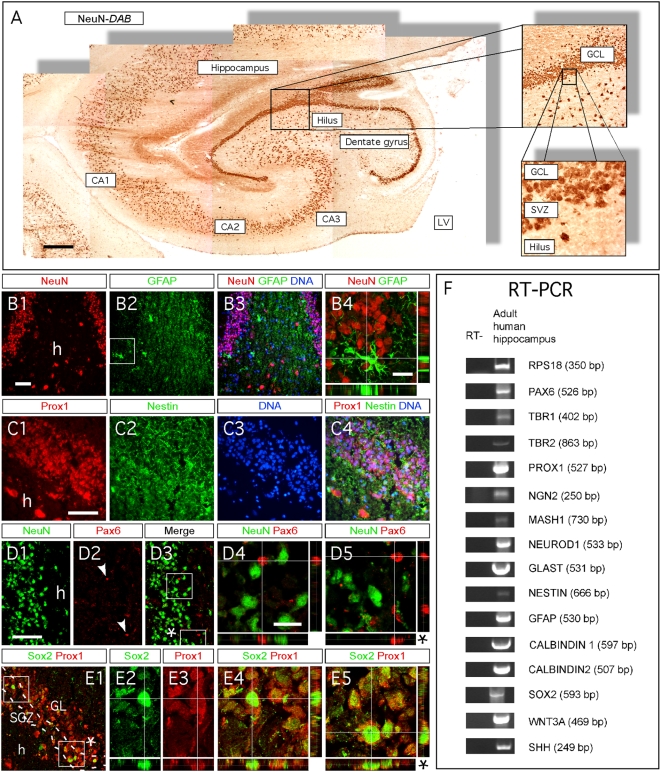
The expression pattern of markers for cell maturation during rodent hippocampal neurogenesis is conserved during human hippocampal neurogenesis.(A–E5) Indirect immunohistochemistries performed on human hippocampal coronal sections of 58-years-old individual. (A) DAB immunohistochemistry for the neuronal marker NeuN shows the neuro-anatomical structure of the hippocampus. (B1–B4) Mature granule neurons and astrocytes/radial glia-like cells express NeuN (green) and GFAP (red), respectively. (C1–C4) Neurons located in the DG express the granule neuron identity marker Prox1. (D1–D5) Pax6 and NeuN expression do not co-localize, suggesting the existence of astrocytes/radial glial stem cell in human hippocampus. (E1–E5) The presence of Sox2+ cells in the SVZ of the DG suggests the occurrence of ongoing neurogenesis. (F) The existence of radial glia stem cells in the human hippocampus is identified by RT-PCR for the markers Pax6, GFAP and GLAST. The molecular bibliography of cellular markers and transcription factors expressed during hippocampal neurogenesis in rodents is conserved during hippocampal neurogenesis in human. Rectangular images on the bottom and right of the panels B4, D4 and D5, E4 and E5 represent a projection of 14-Z stacks images (total of 10–14 µm thick) from framed areas or pointing arrows in panels B2, D3 and E1. The white crosshairs in these panels were positioned to show co-expression in single cells of markers of interest, as labeled above each panel. Arrows and arrowheads point at cells of interest. CA = cornu ammonis, LV = lateral ventricle, SGZ = sub granular zone, GCL = granule cell layer, SVZ = subventricular zone, h = hilus. Scale bars: 300 µm (A), 50 µm (B1–3, C1–4, D1–3 and E1), 25 µm (B4, D4, D5 and E2–5).